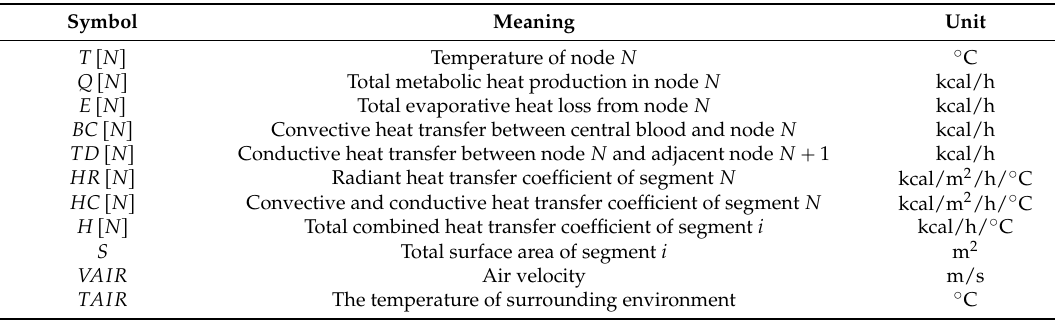
Figure 5. The multi-node model of human body temperature regulation. Table 1. Definition of symbols in the human body temperature regulation model.